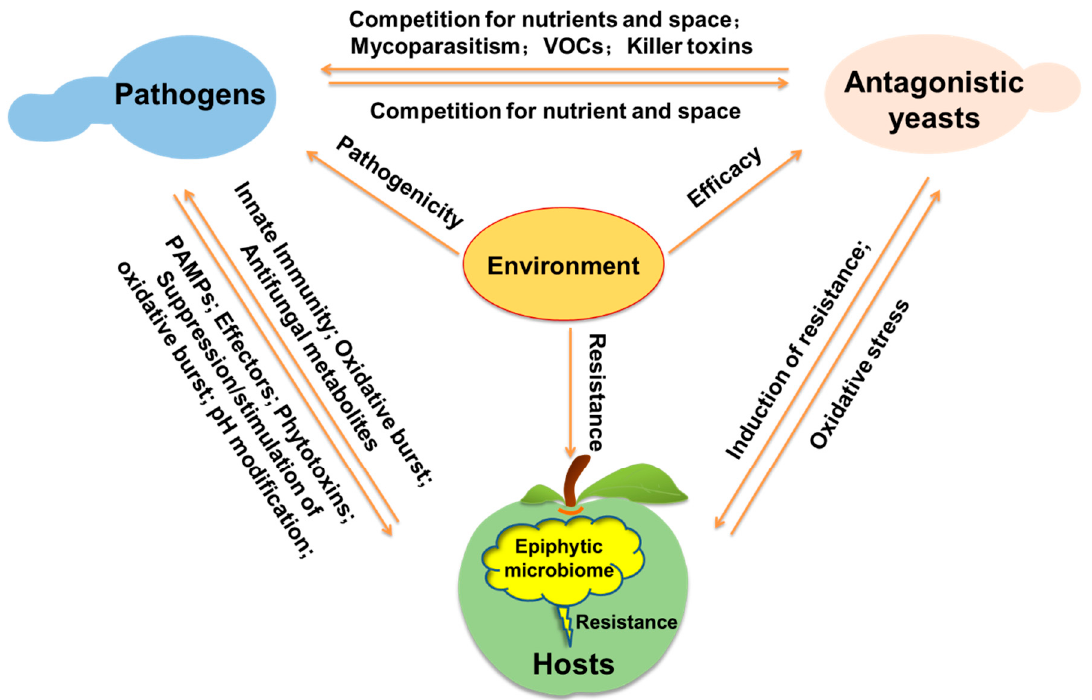
Figure 2. Schematic diagram of the possible interactions among components of the biocontrol system, including the pathogens, antagonistic yeasts, host, epiphytic microbiome, and environment. Antagonistic yeasts can inhibit pathogens through competition for nutrient and space, mycoparasitism, VOCs, and killer toxins. Conversely, pathogens also compete with antagonistic yeasts for nutrient and space to affect their colonization and growth. In addition, antagonistic yeasts can induce the resistance of hosts to inhibit infection, while reactive oxygen species (ROS) produced by hosts may be an oxidative stress to yeasts. During the interaction between fruit hosts and pathogens, hosts can resist the pathogen attack through oxidative burst, innate immune system, and antifungal metabolites, while pathogens can suppress host resistance through pathogen-associated molecular patterns (PAMPs), effectors, phytotoxins, pH modification, and suppression or stimulation of the oxidative burst. The epiphytic microbiome on hosts is also associated with the host resistance. Moreover, environmental conditions have a wide influence on the pathogenicity of pathogens, the efficacy of antagonistic yeasts, and the resistance of hosts.